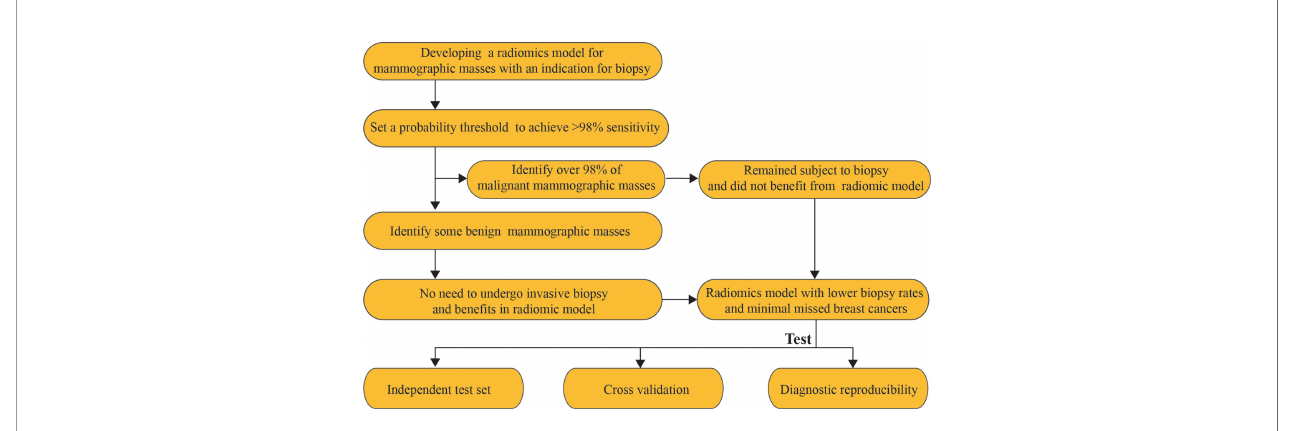
FIGURE 2 | Work fl ows of this